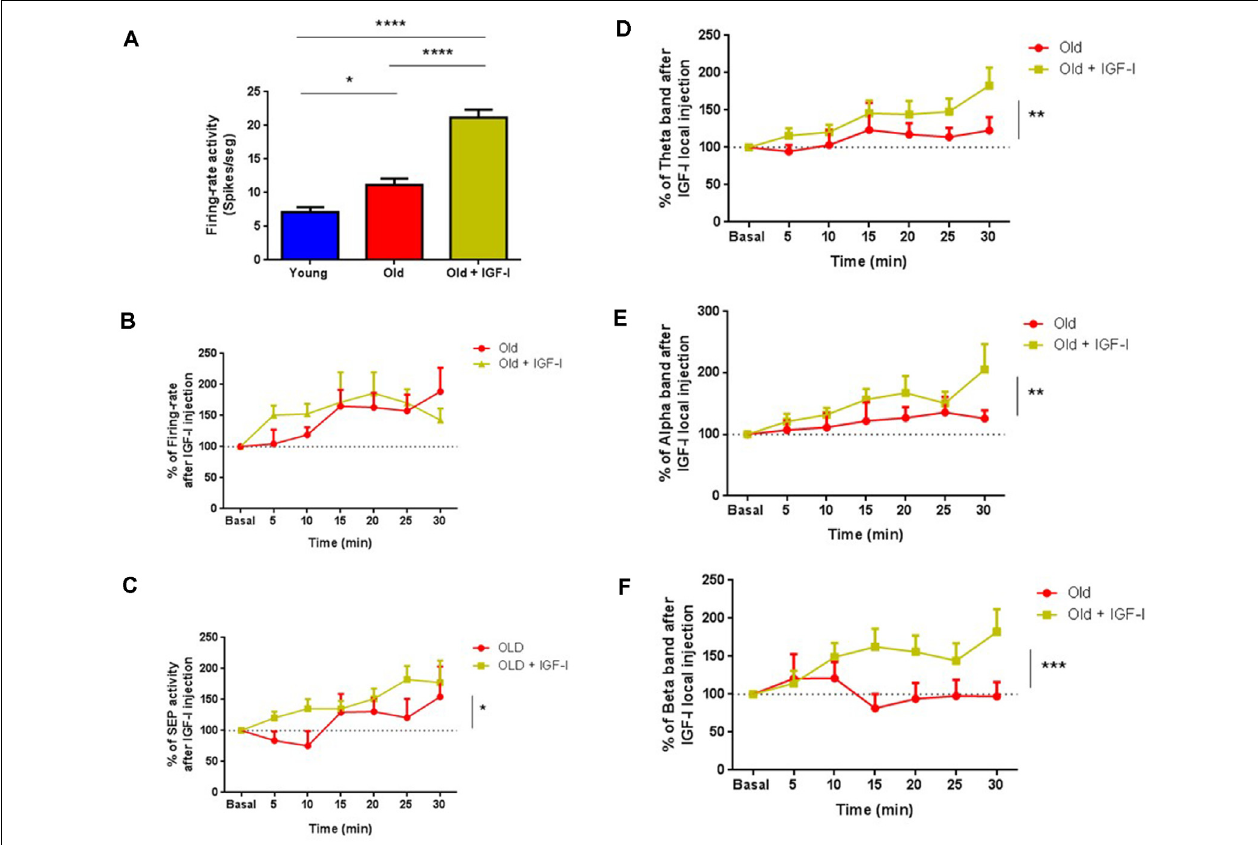
FIGURE 8 | Chronic treatment with hIGF-I recovers cholinergic functions in old mice. (A) The firing rate of ChAT+ neurons in old mice (11.19 ± 0.8989, * p = 0.0119; n = 10 neurons) and in hIGF-I treated mice (21.17 ± 1.198; *** p < 0.0001; n = 16 neurons) were greater than in young animals (7.116 ± 0.7164; n = 14 neurons; One-Way ANOVA, *** p < 0.0001, Holm–Sidak’s multiple comparisons test). (B) Identified ChAT+ cells shows similar firing rate in old ( n = 13 neurons) and in old treated animals after IGF-I local injection ( n = 15 neurons, F (1,182) = 0.6,303; p = 0.4,283; Ordinary Two-Way ANOVA). (C) SEP facilitation was faster in old treated mice compare to old animals over 30 min recordings (old = 13 neurons, old treated = 15 neurons, F (1,180) = 5.868, * p = 0.0164, Ordinary Two-Way ANOVA). (D–F) ECoG frequency band analysis showed differences between both groups (old = 13 animals, old treated = 15 animals) in θ band ( F (1,180) = 8.075; ** p = 0.0050), α band ( F (1,166) = 6.790; ** p = 0.001) and β band ( F (1,182) = 14.08; *** p < 0,0002; Ordinary Two-Way ANOVA) over 30 min recordings. **** p <